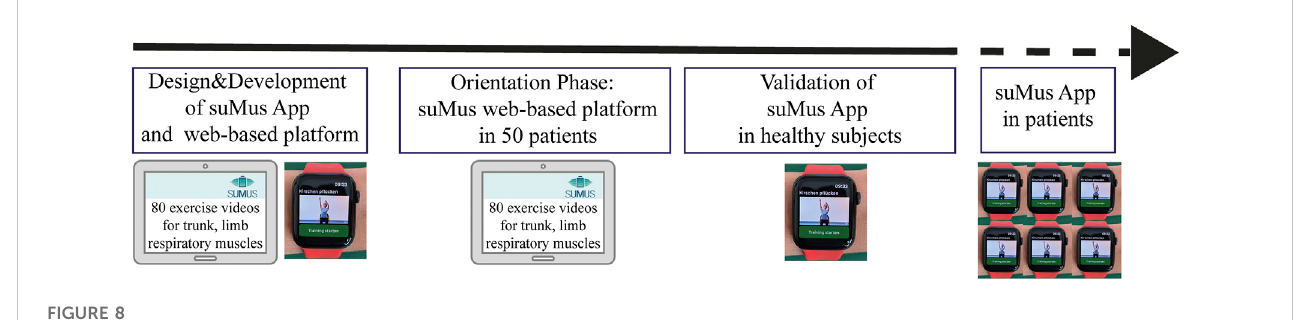
FIGURE 8 suMus Roadmap. Critical steps of suMus from concept to validation in